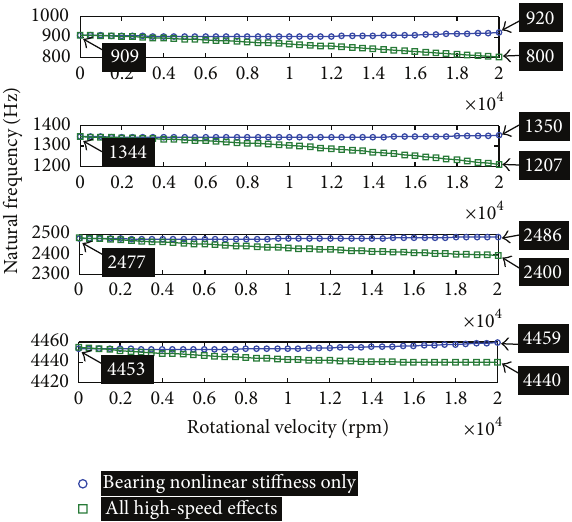
Figure 21: High-speed effects of both shaft and bearing versus high- speed effects of bearing